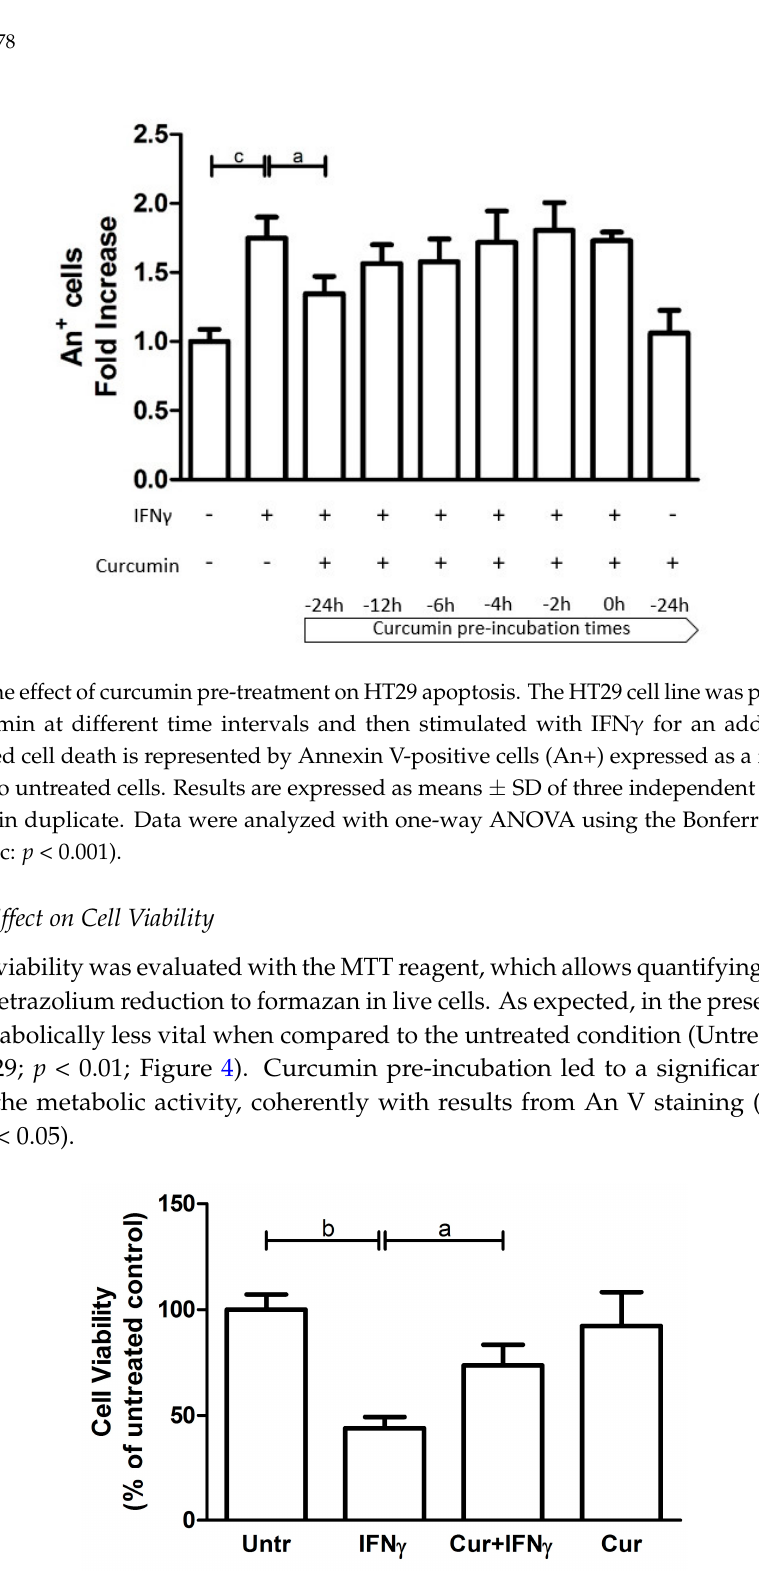
Figure 4. Viability analysis on HT29 pre-stimulated with curcumin. HT29 cell line was pre-incubated with curcumin (Cur) and after 24 h stimulated with IFN γ for an additional 48 h, to evaluate cell viability through MTT assay. Results are expressed as means ± SD, in percentage (%), normalized to the control condition (Untr). Data were analyzed with one-way ANOVA using the Bonferroni post-test (a: p < 0.05; b: p < 0.01).